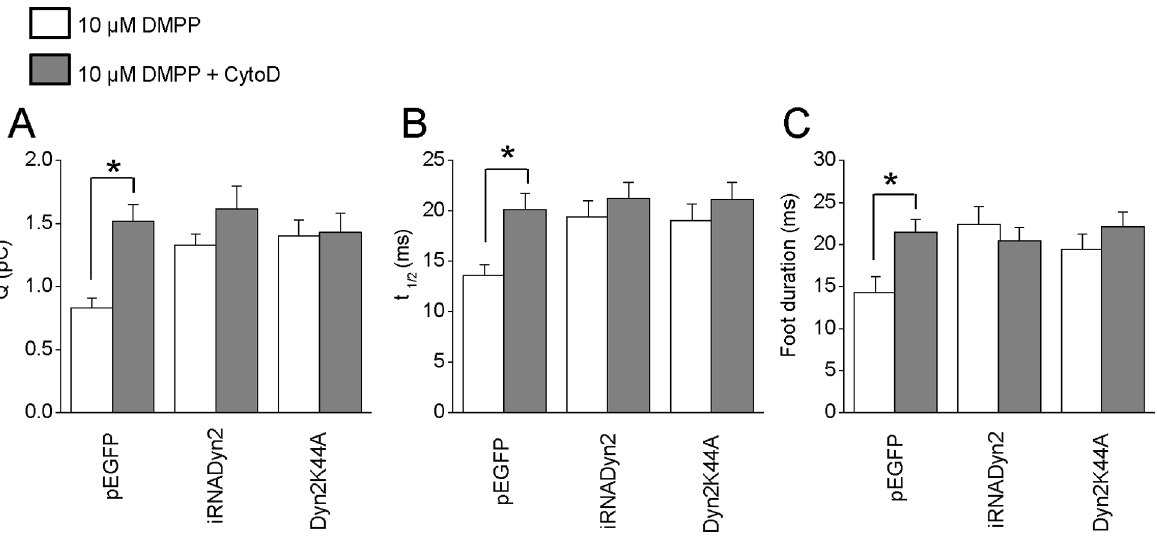
Figure 6. Dynamin-2 and actin polymerization regulate the fusion pore expansion and quantal size in BCC. Chromaffin cells were incubated with 4 m M CytoD during 10 minutes at 37 u C. After that the exocytosis was evoked with 10 m M DMPP. A–C: Data show average values 6 SEM of Q (A), t 1/2 (B) and foot duration (C) of amperometric spikes induced by 10 m M DMPP in cells transfected with pEGFP (n=27), Dyn2K44A (n=13) or iRNADyn2 (n=16). All amperometric parameter values correspond to the median values of the events from individual cells, which were subsequently averaged per treatment group. Thus, n correspond to the number of cells in each treatment group. Note that the CytoD treatment (grey bars) significantly increased Q, t 1/2 and foot duration of the exocytotic events in cells transfected with pEGFP, without additional effects in cells transfected with Dyn2K44A or iRNADyn2. * p , 0.05 compared with the untreated cells (Kruskal-Wallis test).